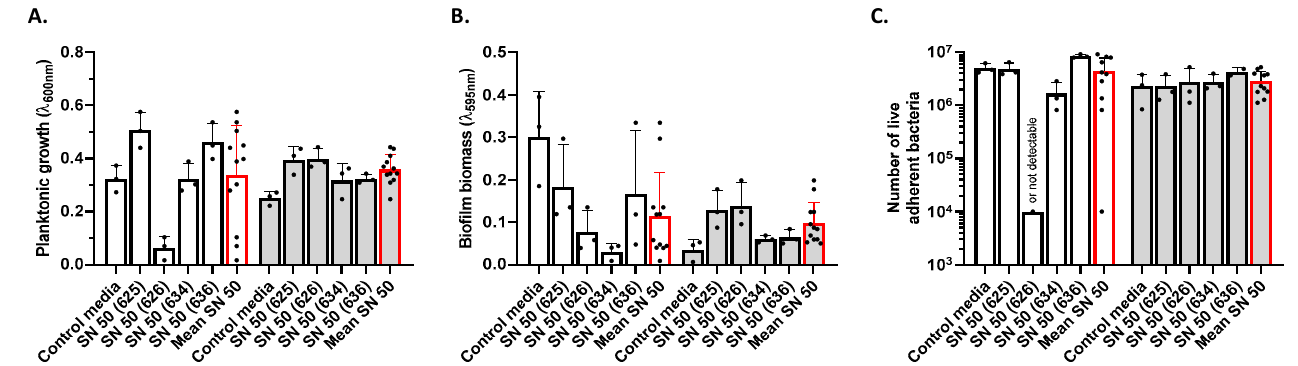
Figure 6. Impact of primary osteoblast culture supernatant on S. aureus planktonic growth and biofilm biomass. Results represent planktonic growth ( A ), biofilm biomass ( B ), and number of live adherent bacteria ( C ) for SH1000 (white histogram) and USA300 (grey histogram). Control media (50% [DMEM + 10% FBS] and 50% MM), SN 50 (625, 626, 634, and 636) (50% primary human osteoblast culture supernatant and 50% MM), or All SN 50 (addition of results of SN 50 (625, 626, 634, and 636)). n = 2 to 3.